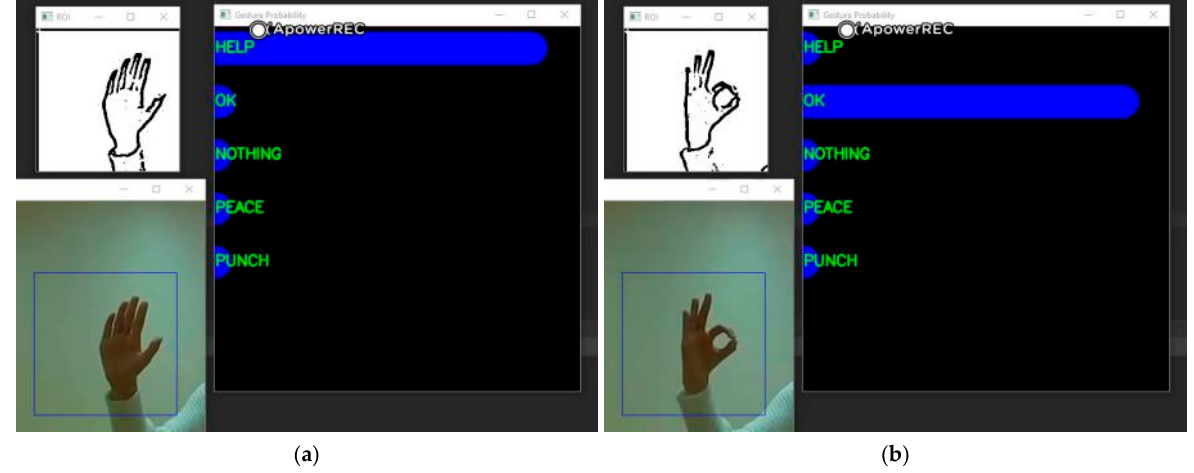
Figure 14. Help hand gesture recognition ( a ) and Ok hand gesture recognition ( b ).